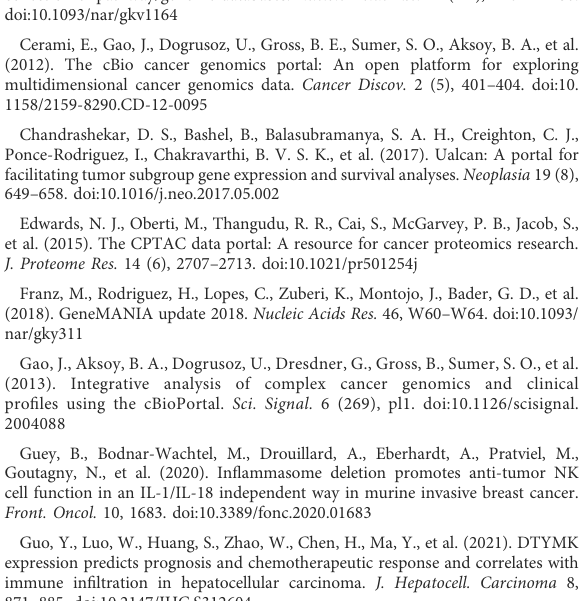
SUPPLEMENTARY FIGURE S1 Protein expression of DTYMK. The updownregulated protein of DTYMK was detected in BRCA (A) , and KIRC (B) . (ns, no signi fi cant; *, P < 0.05, ***, P < 0.001). SUPPLEMENTARY FIGURE S2 Promoter methylation level of DTYMK. No signi fi cant difference of promoter methylation level were found in BRCA (A) , CHOL (B) , COAD (C) , CESC (D) , ESCA (E) , GBM (F) ,KIRP (G) , LUSC (H) , PAAD (I) , PCPG (J) , READ (K) , SARC (L) , SKCM (M) , STAD (N) , THCA (O) , and THYM (P). (ns, no signi fi cant). SUPPLEMENTARY FIGURE S3 The correlation between DTYMK expression and age and gender. (A – G) DTYMK expression was correlated with age in ESCA, KIRP, LGG, OV, SARC, STAD, and THYM. (H,I) DTYMK expression was correlated with gender only in HNSC and LUAD. (*, P < 0.05, **, P < 0.01, ***, P < 0.001). SUPPLEMENTARY TABLE S2 The cut-off value, sensitivity, speci fi city, positive predictive value, negative predictive value, and Youden index of DTYMK in Pan-Cancer